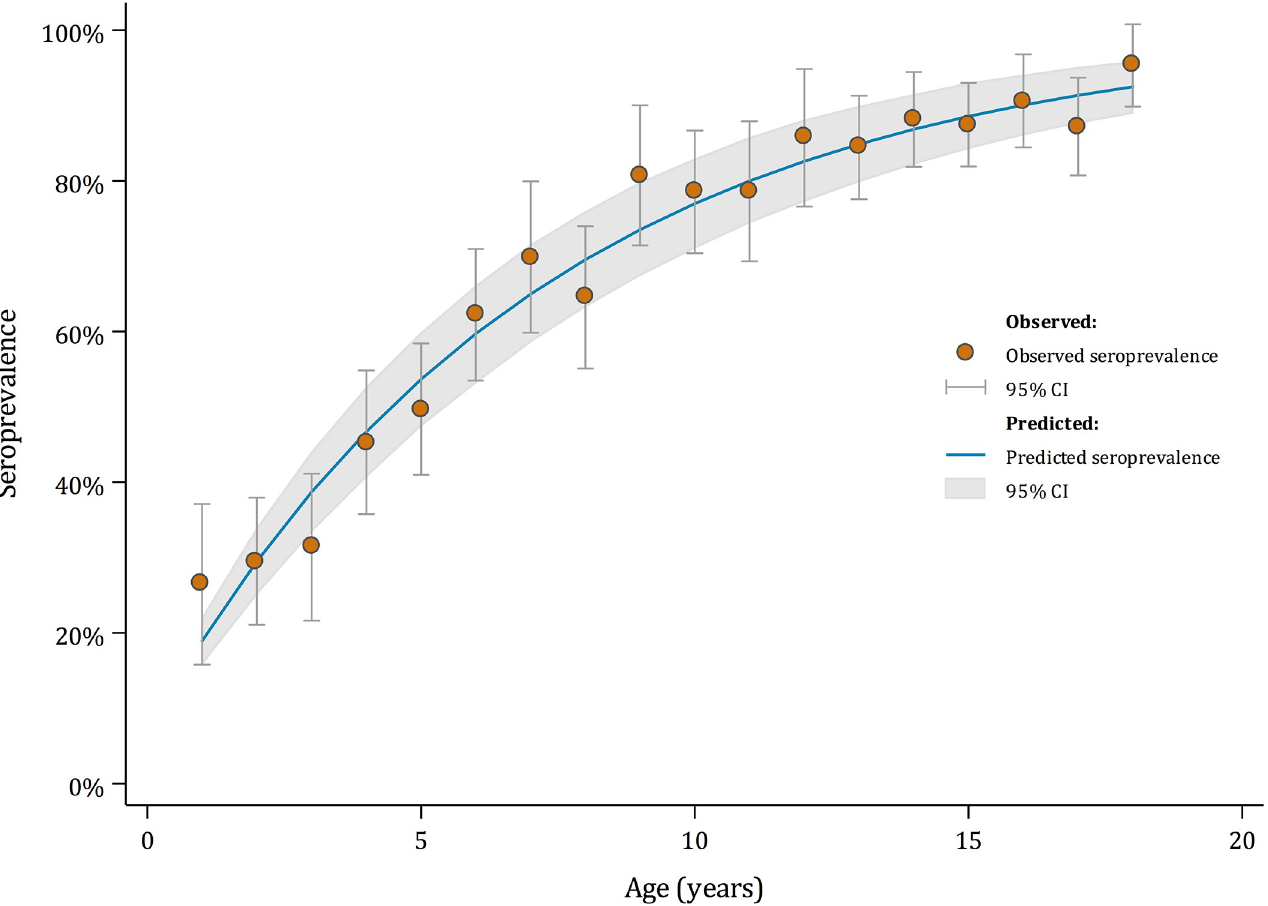
Fig 1. Observed (orange markers) and model-predicted (blue line) seroprevalence by year of age, based on an overall estimated force of infection, λ , of 14.0% per annum, with corresponding 95% confidence intervals, among children aged 1 to 18 years in Indonesia, 2014.